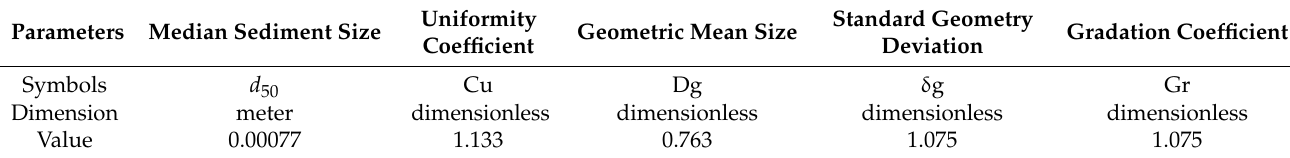
Table 2. Geometric characteristics of sediment